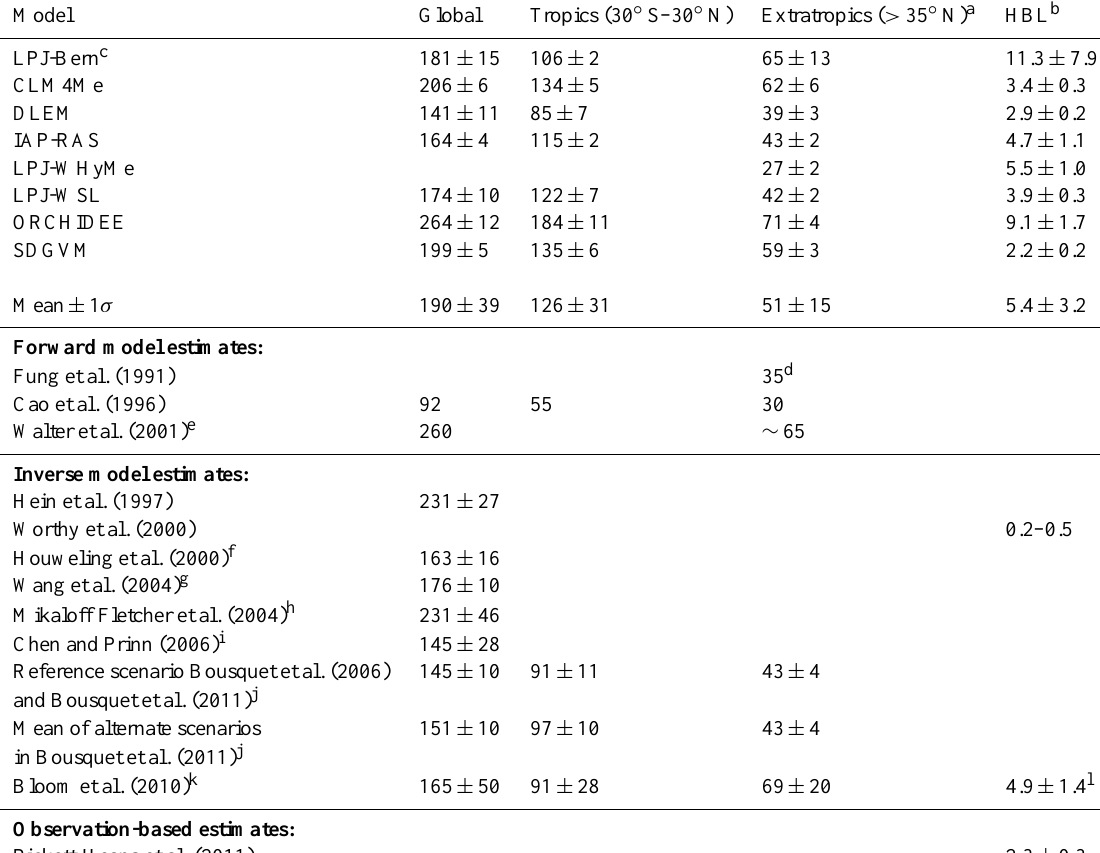
Table 3. Simulated annual mean total methane emitted to atmosphere from natural wetlands for 1993–2004. All units are TgCH 4 yr − 1 ± 1 σ , where the standard deviation represents the inter-annual variation in the model estimates. Note that estimates from some other reference studies are not for the same time period, or are for slightly different geographic regions. These exceptions are noted in the table footnotes.